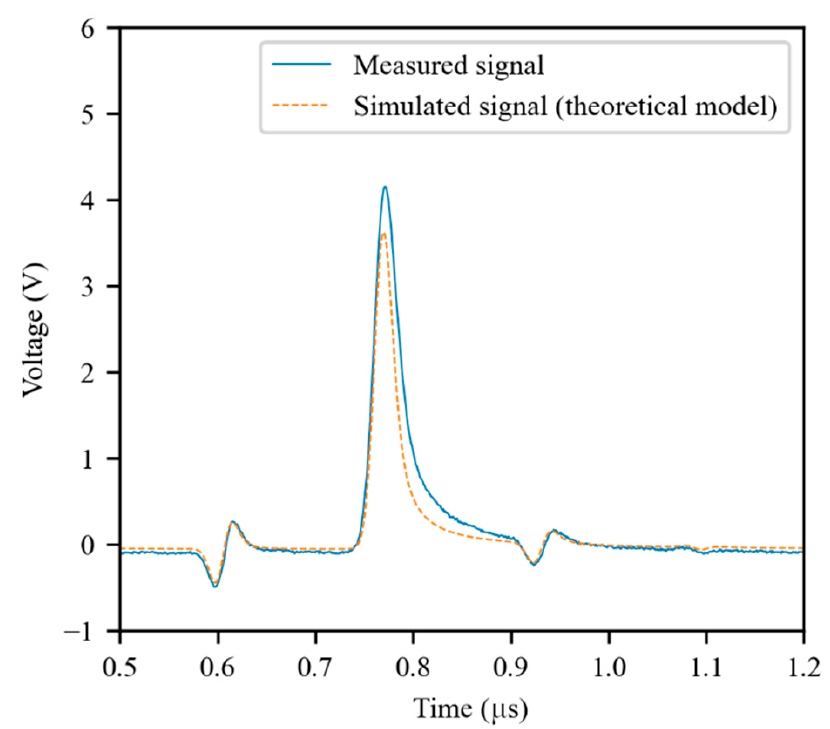
Figure 5. An experimental TDR signal compared with a simulated signal obtained using the theoretical model of the coaxial cable. The cable was 66 m long, with a parallel capacitive fault of 47 pF at 50 m. The first reflected signal is due to the fault, while the second is due to the cable’s open termination.